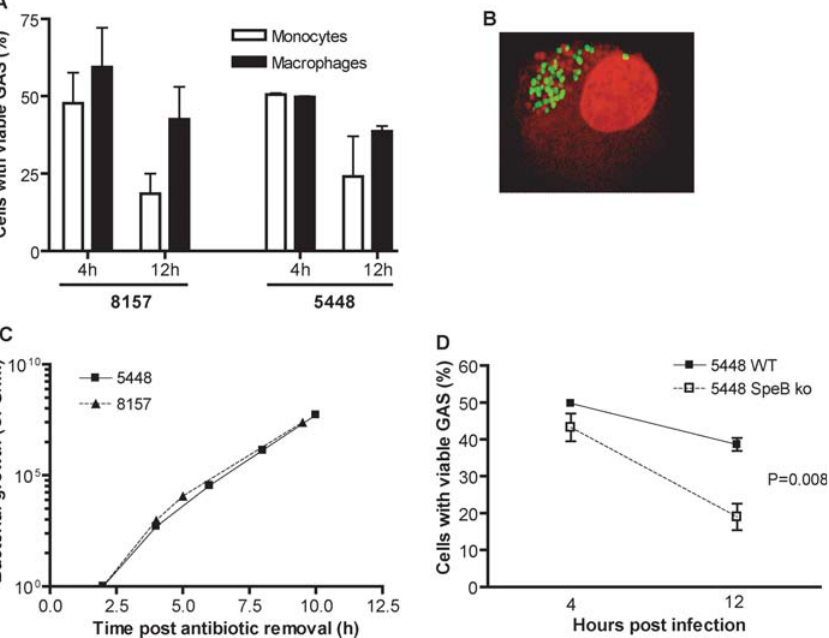
Figure 4. GAS Survive Intracellularly in Monocytes and Macrophages A) Frequency of cells containing viable intracellular bacteria 4 and 12 h postinfection with strains 8157 and 5448, respectively. Bars denote mean 6 SEM of four or five experiments performed using monocytes or macrophages, respectively. (B) A confocal image of a representative macrophage harboring intracellular GAS (viable in green and dead in red) as assessed by staining with a bacterial viability kit. (C) Resurgence of intracellular bacteria (8157 and 5448) in the medium. At 12 h postinfection, antibiotic-free medium was